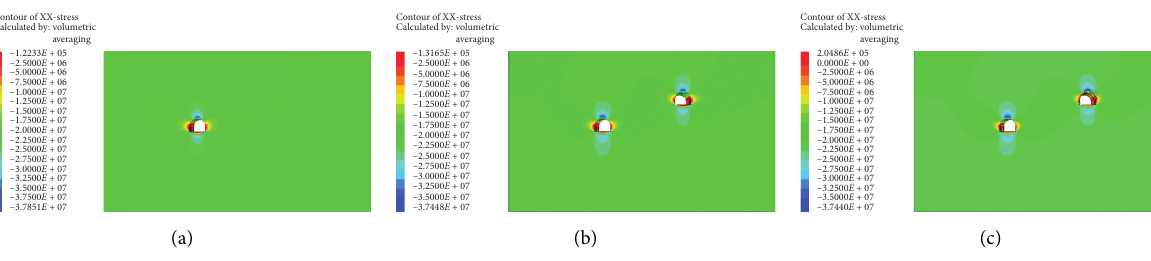
Figure 10: Model principal stress distribution when the roadway moves vertically for 10m: (a) excavation of the left side roadway, (b) excavation of the right-side roadway, and (c) load seismic wave.